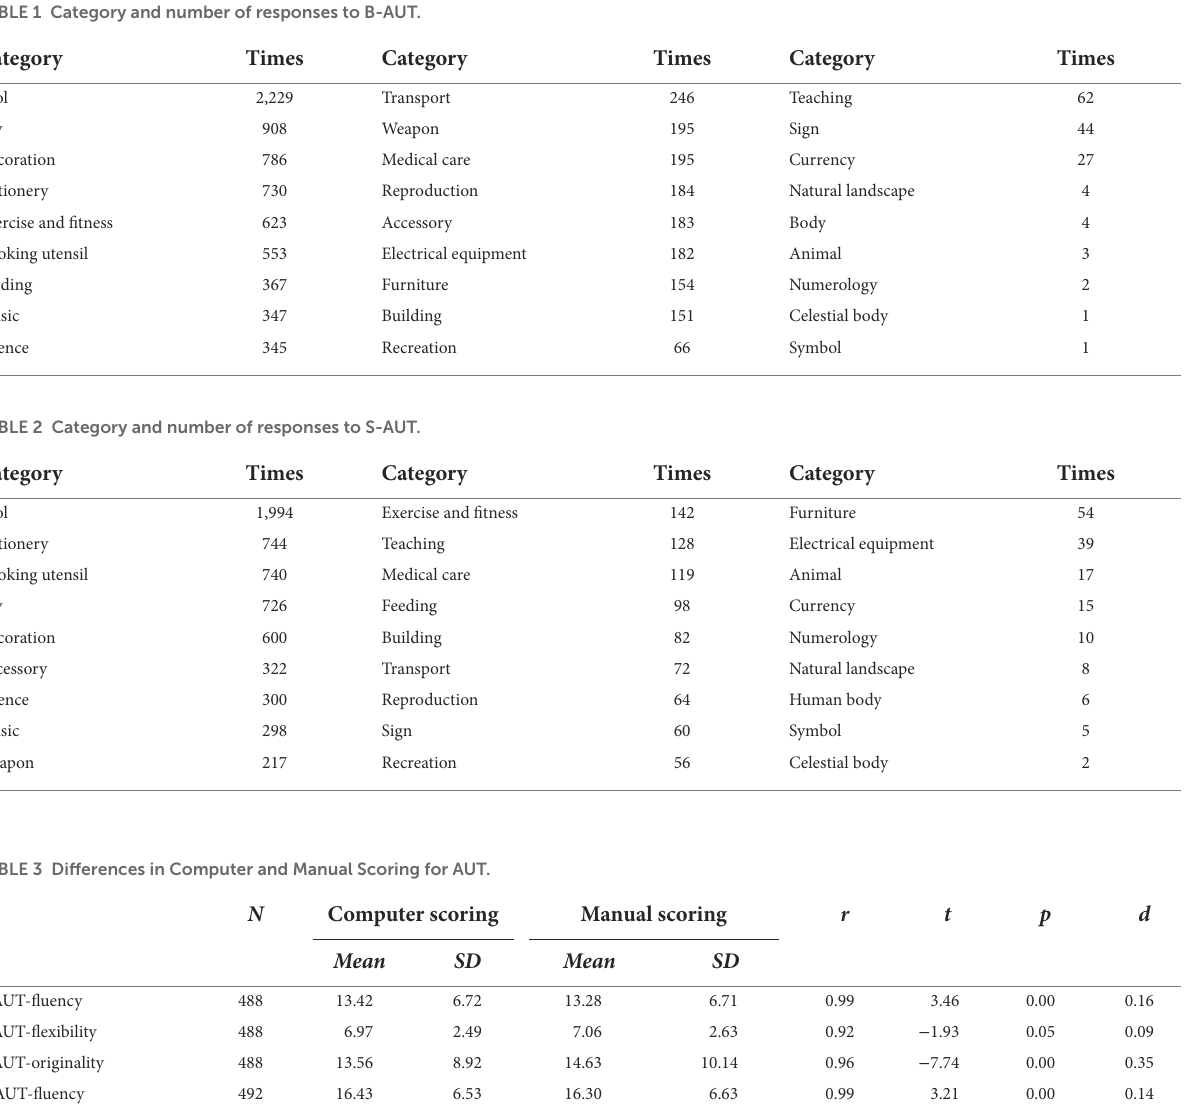
TABLE 1 Category and number of responses to B-AUT.